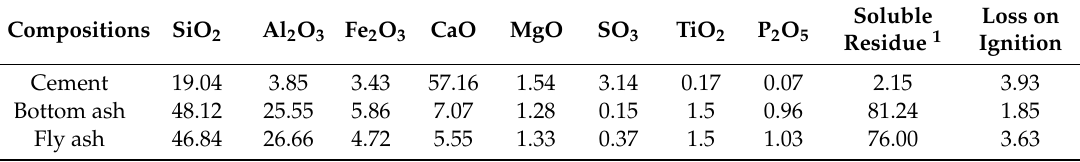
Soluble Loss on Residue 1 Ignition